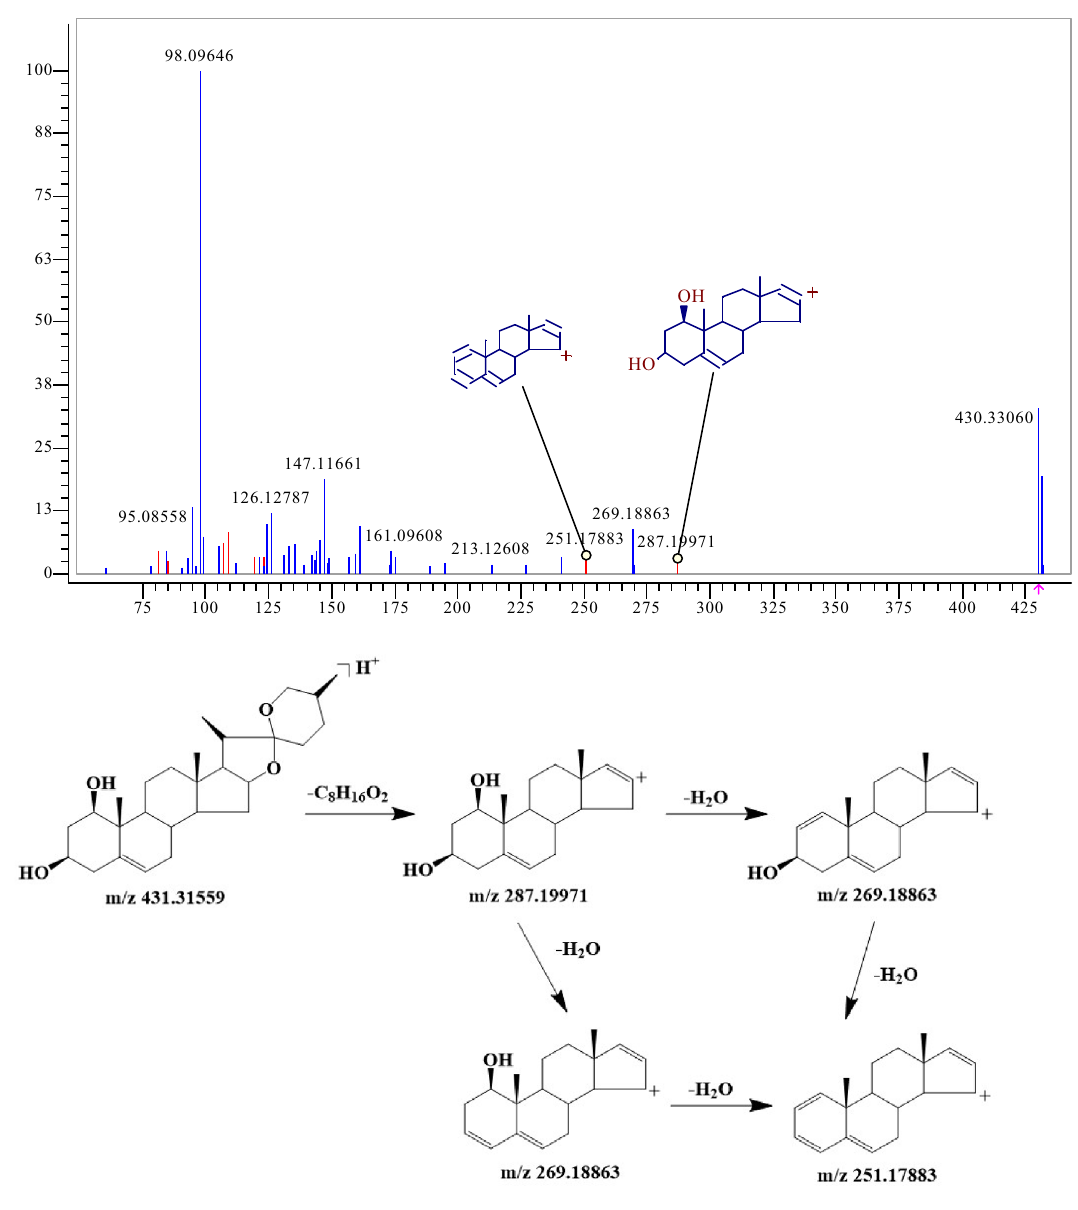
Figure 4. MS 2 spectra and cracking diagram of